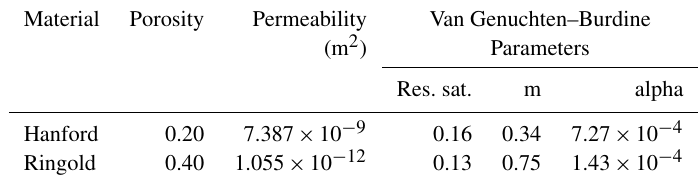
Table 2. Hydrogeological material properties of Hanford and Ringold materials. “Res. sat.” denotes residual saturation.